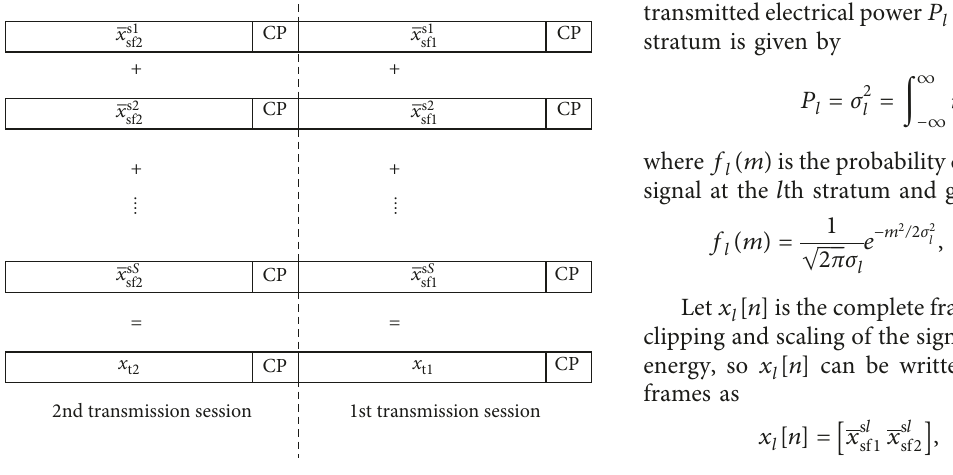
Figure 4: STACO-OFDM frame